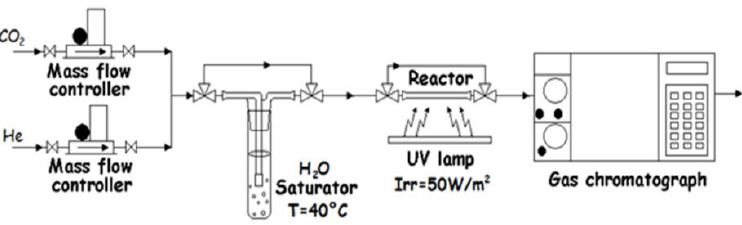
Figure 13. Lab-made gas line employed for the photo-catalytic